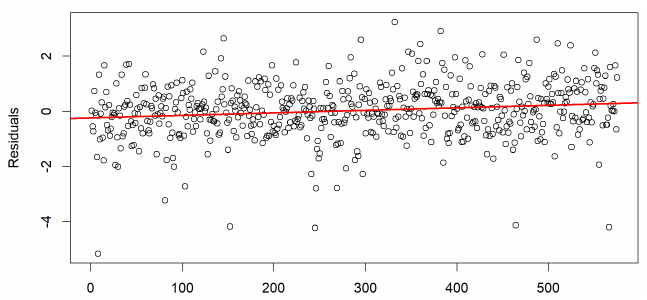
Figure 14. Regression Plot for the TGARCH Residual Distribution.